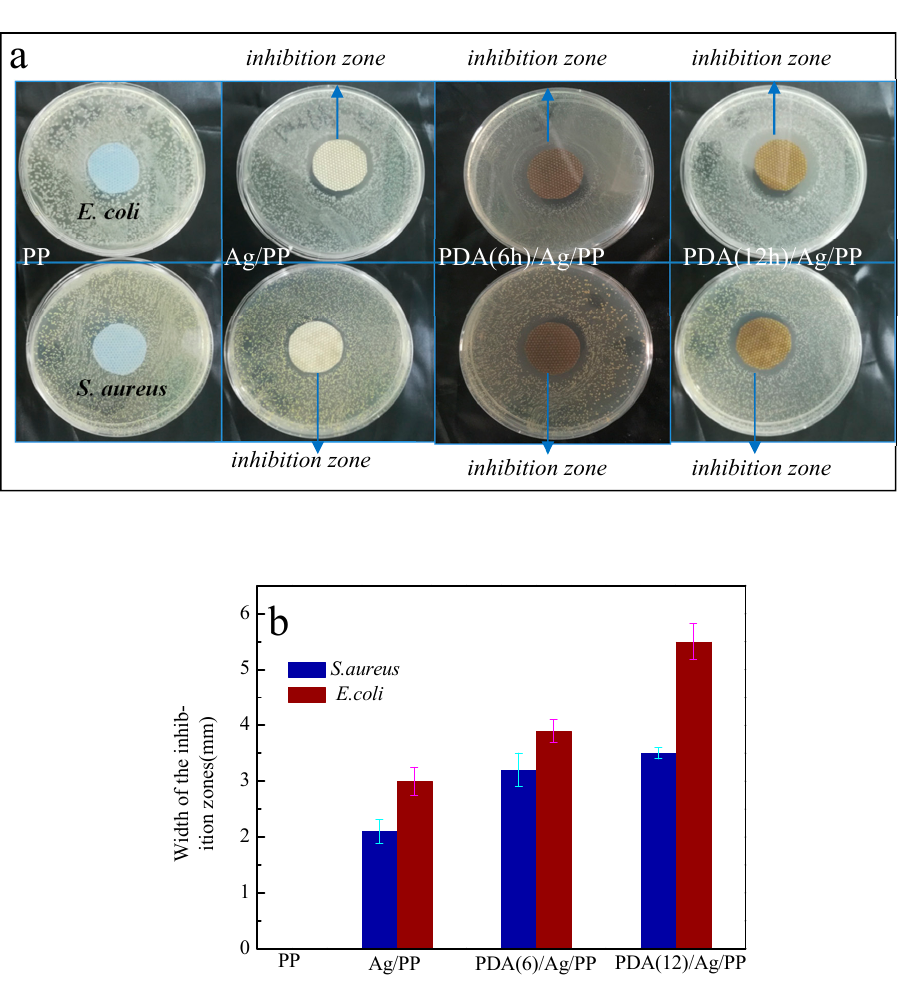
Figure 9. The antibacterial activity of the treated and untreated fabric: ( a ) images of antibacterial activity of the fabrics; ( b ) widths of the inhibition zone.